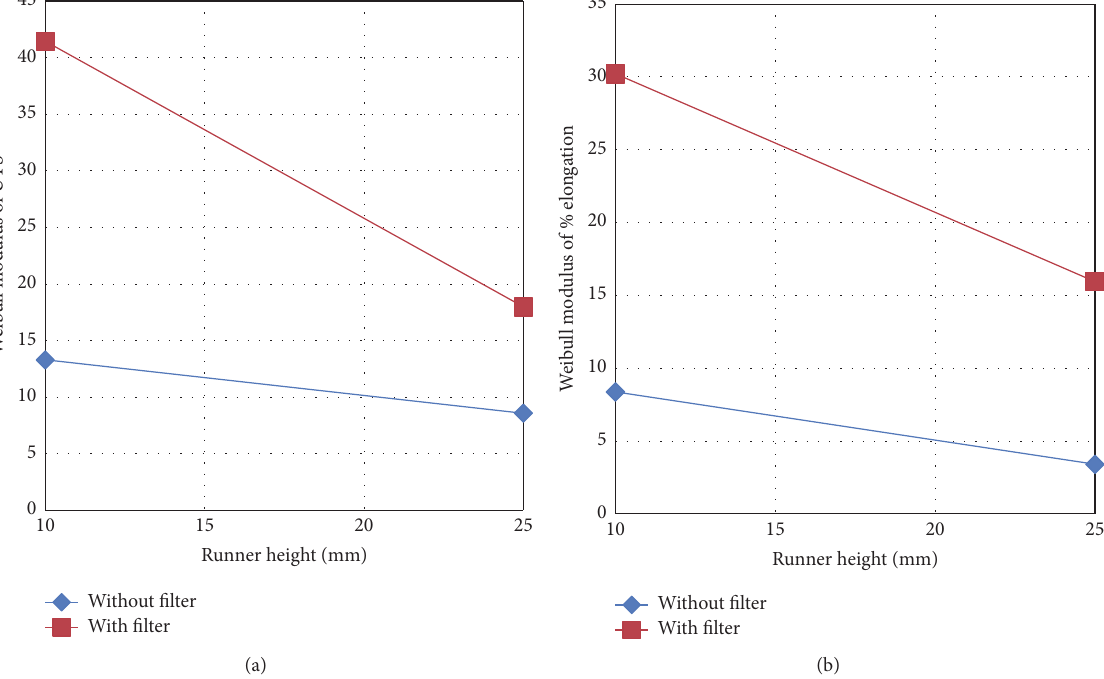
30.22 were obtained when a 10 mm thick runner was used, when filters were implemented, or when both the thin runner and the filters were